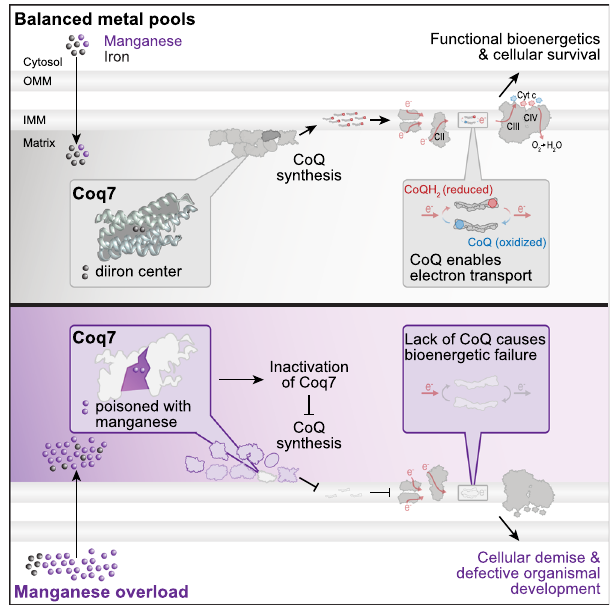
Fig. 7 | Model of Mn-induced CoQ de fi ciency, resulting in bioenergetic failure. Cellular Mn overload, induced by genetic or environmental means, translates into overaccumulation of Mn in mitochondria, which interferes with the correct metallation of the diiron hydroxylase Coq7. In turn, loss of Coq7 compromises CoQ production and precludes CoQ-mediated electron transfer in the electron transport chain. The resulting bioenergetic failure drives cellular and organismal